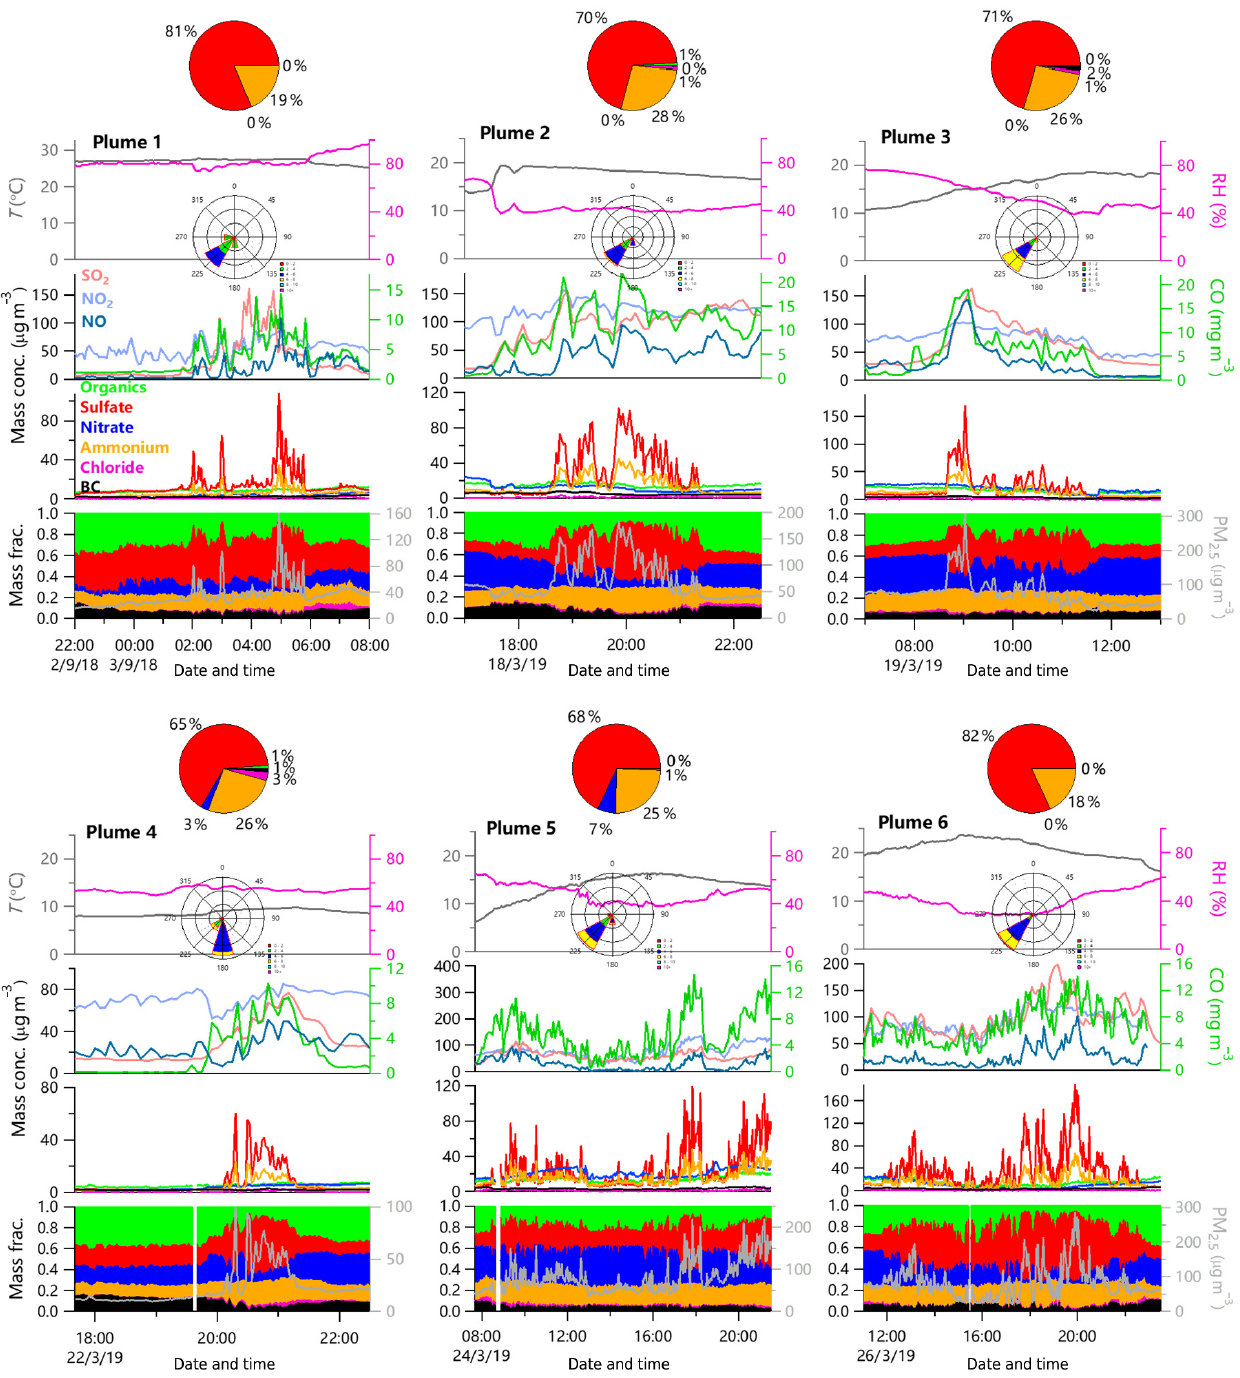
Figure 7. Evolution of meteorological parameters including T and RH, gaseous species, mass concentrations, and mass fractions of chemical species in PM 2 . 5 during six steelworks plume episodes. The pie charts show the contribution of each species emitted completely from steel plants. The wind rose plots depict the prevailing wind direction during each plume